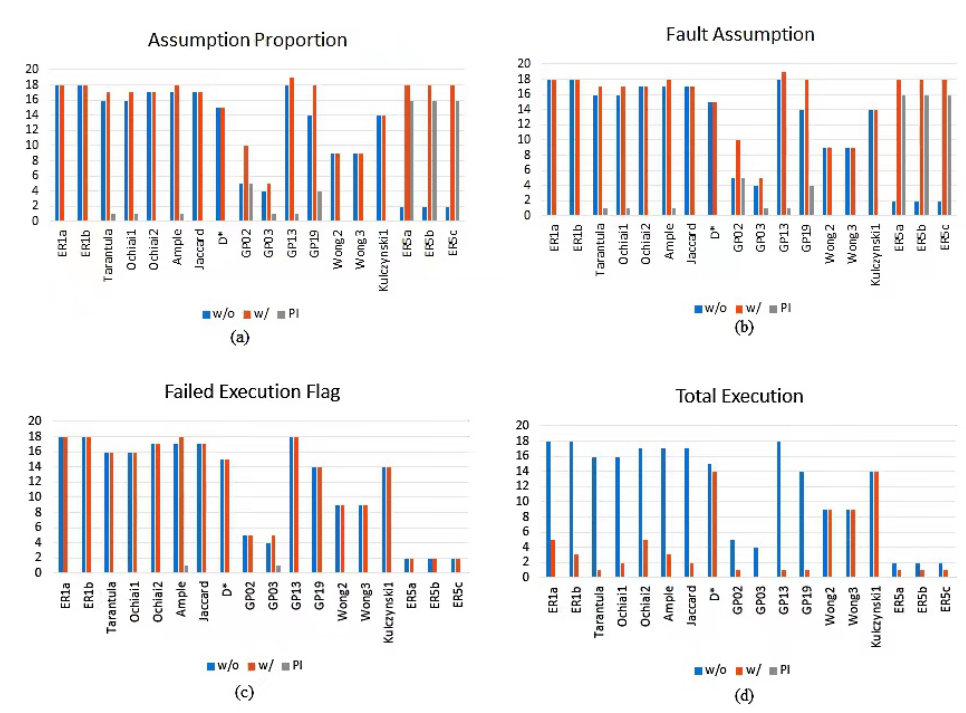
Figure 2. Percentage of increase in the fault localization accuracy, acc@1, of the existing formulas with or without the proposed metrics: Assumption Proportion, Fault Assumption, Failed Execution Flag, and Total Execution. PI: Percentage of Improvement. w/o: without metric. w/: with metric. ( a ) the effect of Assumption on the existing maximal formula. ( b ) the effect of Fault Assumption. ( c ) the effect of Failed Execution Flag. ( d ) the effect of Total